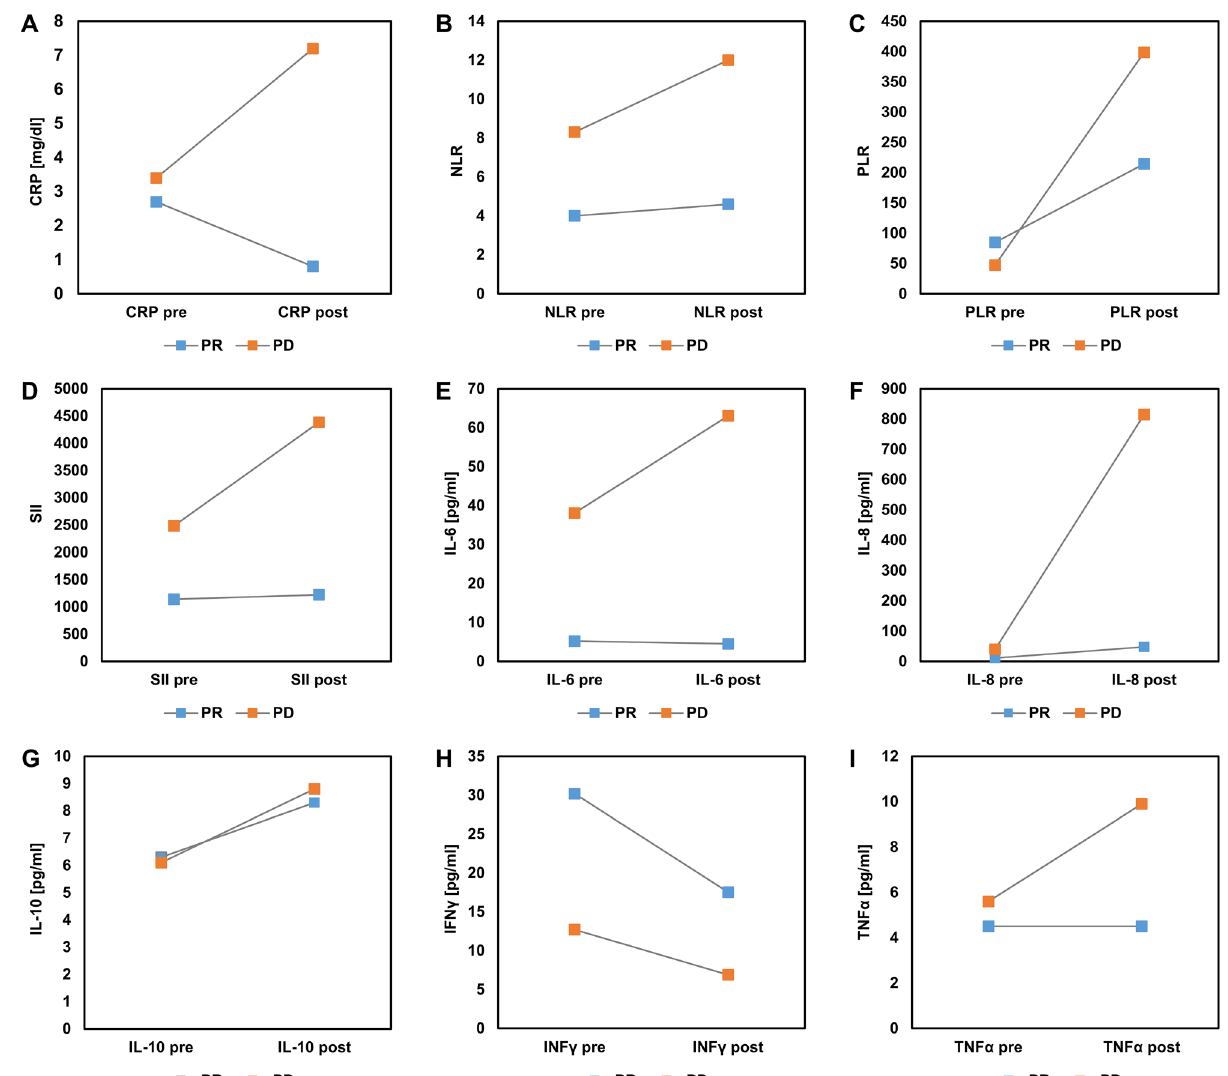
Figure 5. Dynamics of pre-therapeutic to first staging inflammatory scores and cytokine. ( A ) CRP, ( B ) neutrophil to lymphocyte ratio (NLR), ( C ) platelet to lymphocyte ratio (PLR), ( D ) systemic inflammation index (SII), ( E ) interleukin 6 (IL-6), ( F ) interleukin 8 (IL-8), ( G ) interleukin 10 (IL-10), ( H ) interferon gamma (IFN-γ) and ( I ) tumor necrosis factor alpha (TNFα).